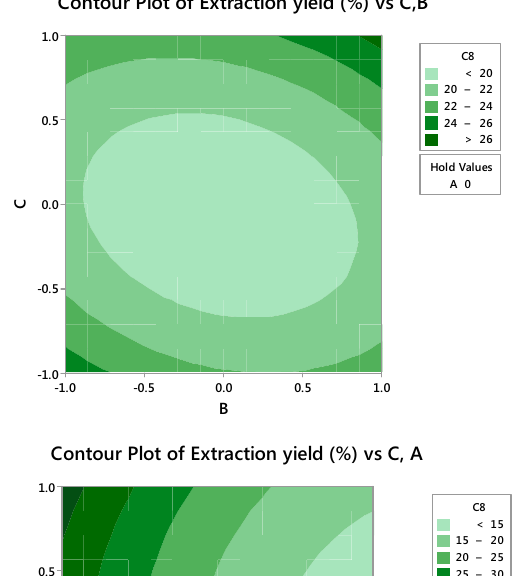
Table 11 Screening for Y (% Extraction yield) by RSM